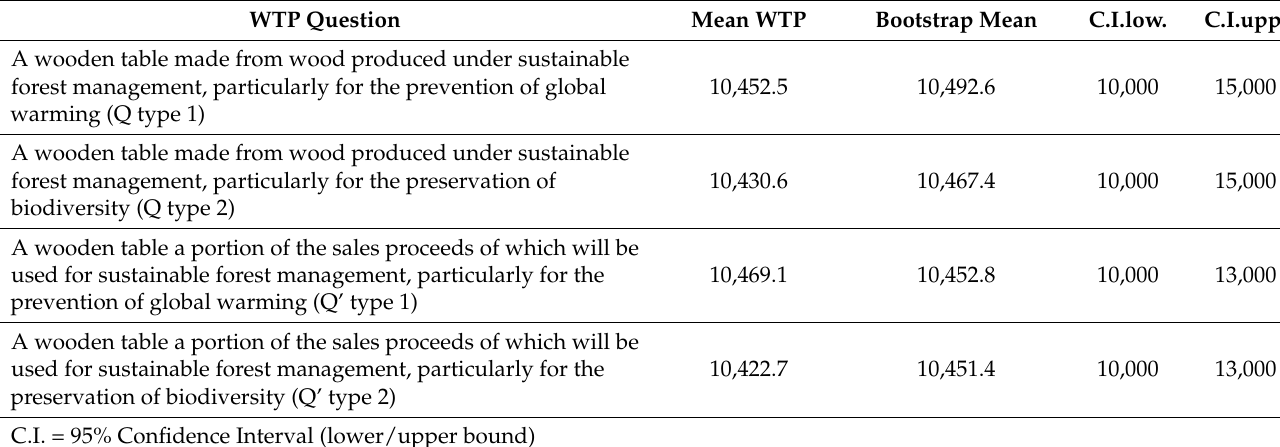
Table 4. Results of the WTP Estimates using CV: Q and Q’